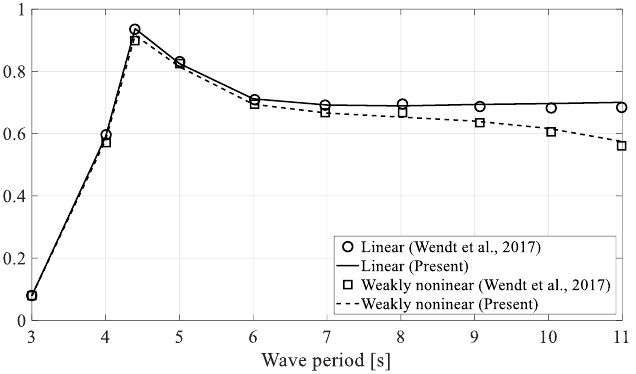
Figure 5. Comparison of heave RAO of the sphere with PTO damping (wave steepness = 0.0628).